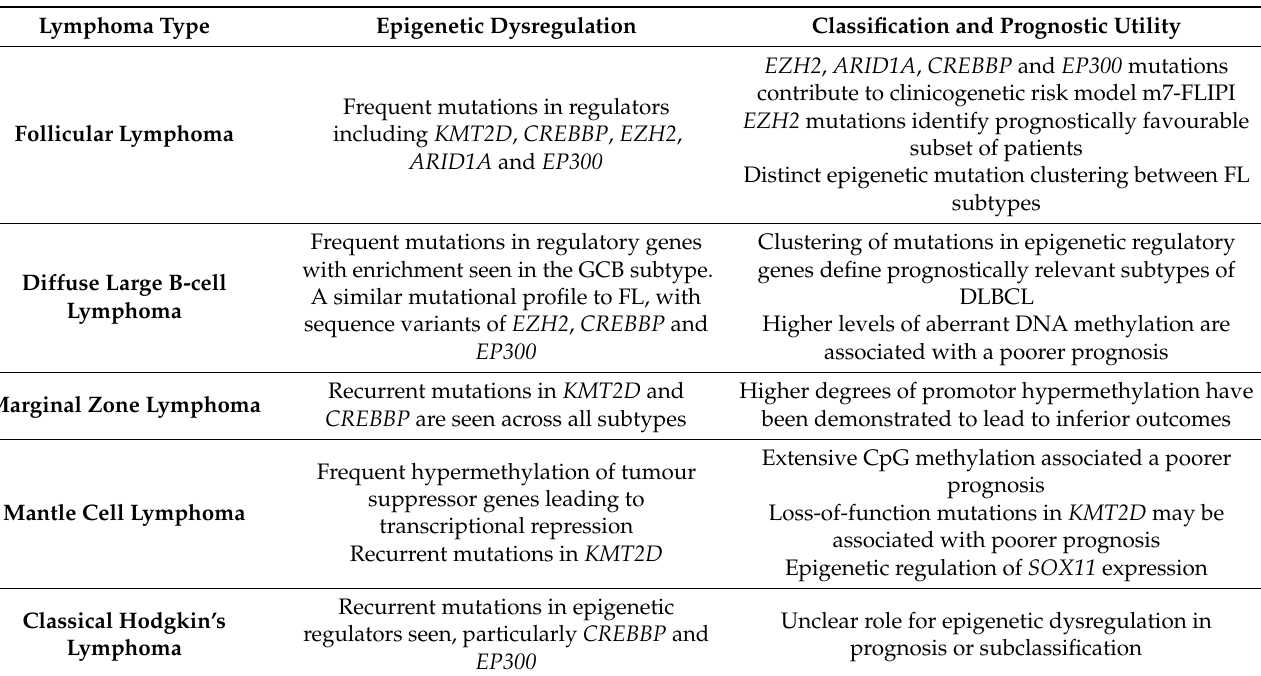
Table 2. Utility of epigenetic dysregulation to classification and prognostication in lymp- homa